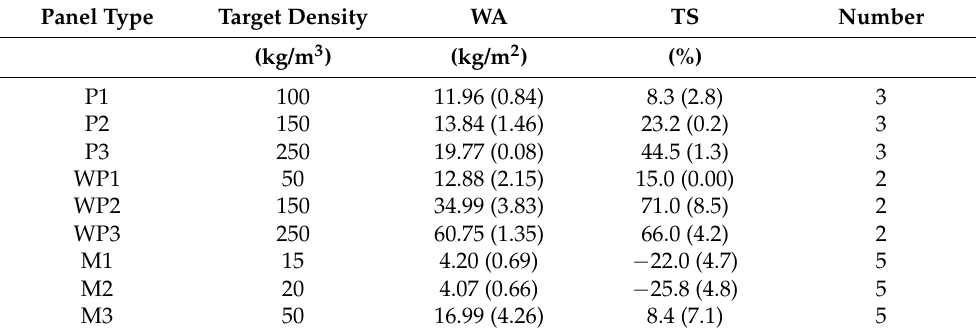
Table 5. Water absorption and thickness swell of peat moos samples (SD in